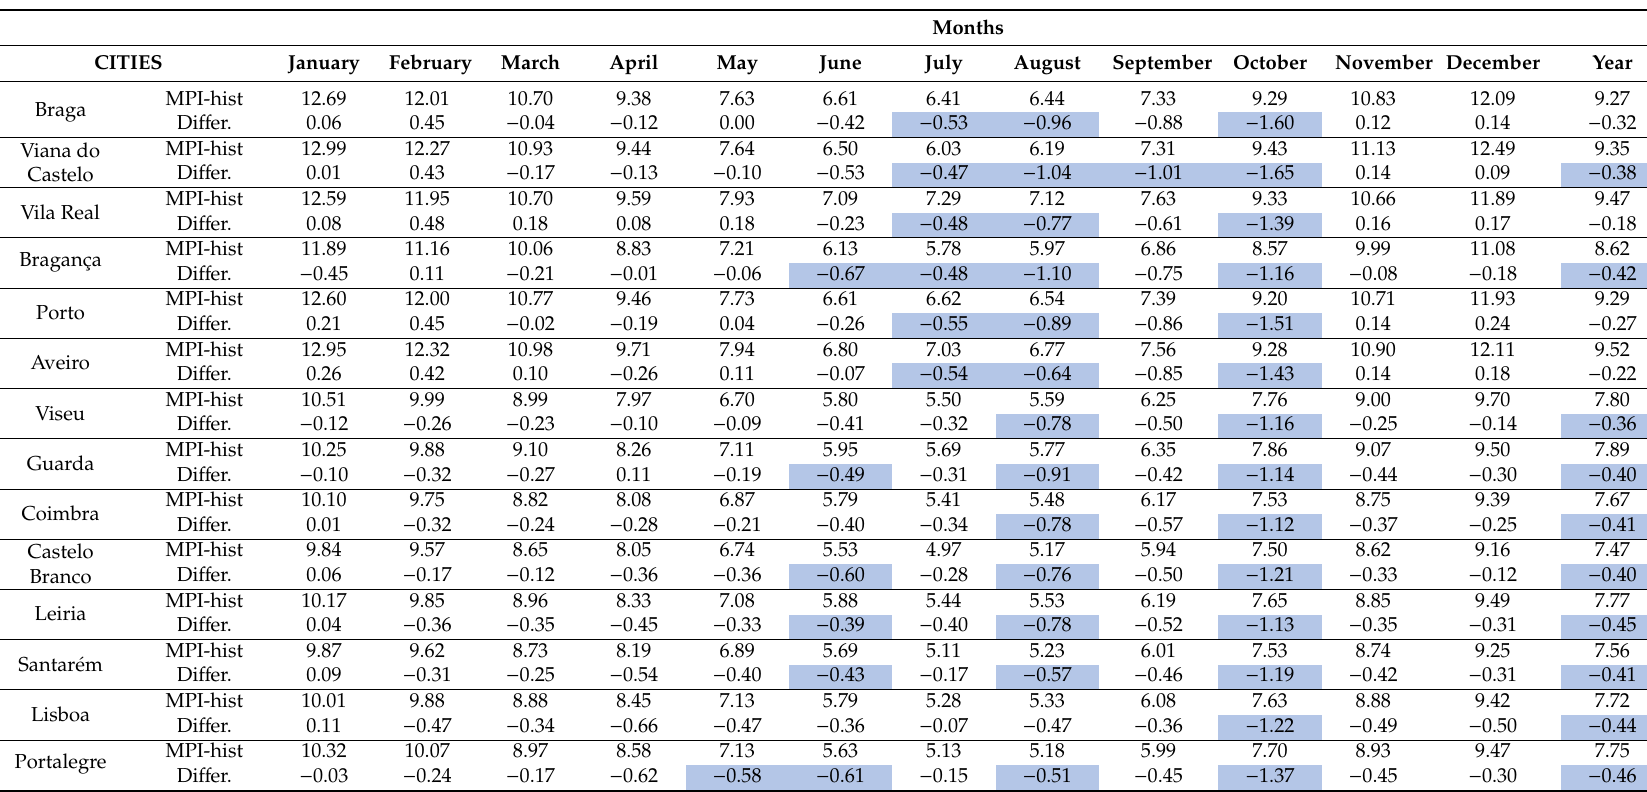
Table 6. Monthly and annual averaged wind speed at 850 hPa for each city and the di ff erence between the future and the historical climates. Significant di ff erences ( t -student 5%) are shown in red (positive) and blue